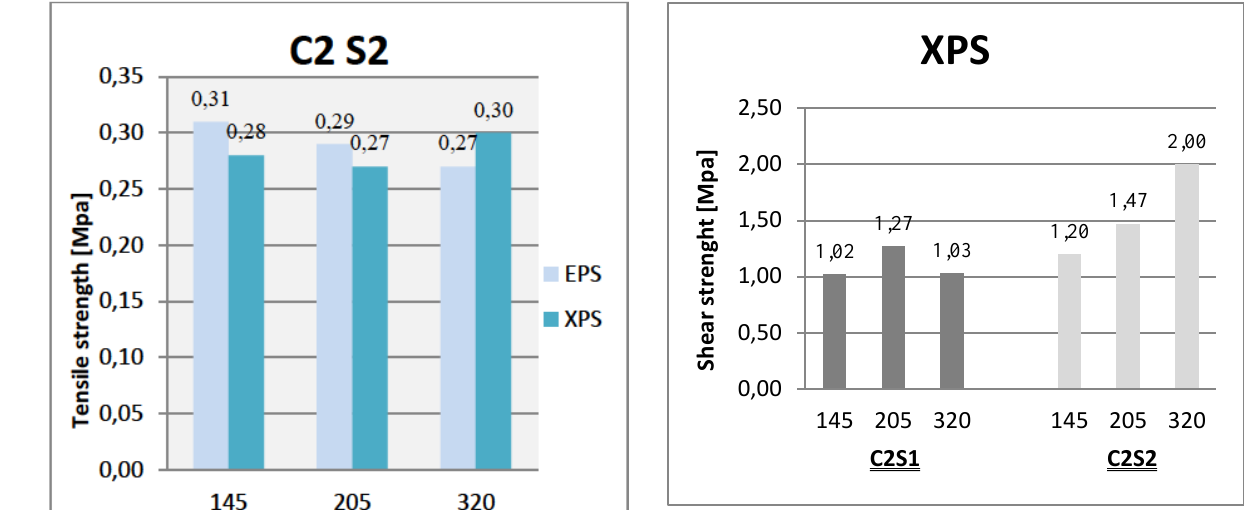
better adhesion. Only with a mesh weight of 205 g/m2, de- viations are smaller 3-7%.